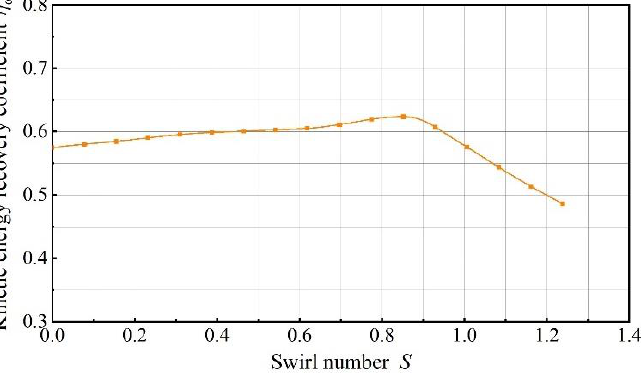
Figure 11. Variation of kinetic energy recovery coefficient of outlet conduit in different swirl numbers.